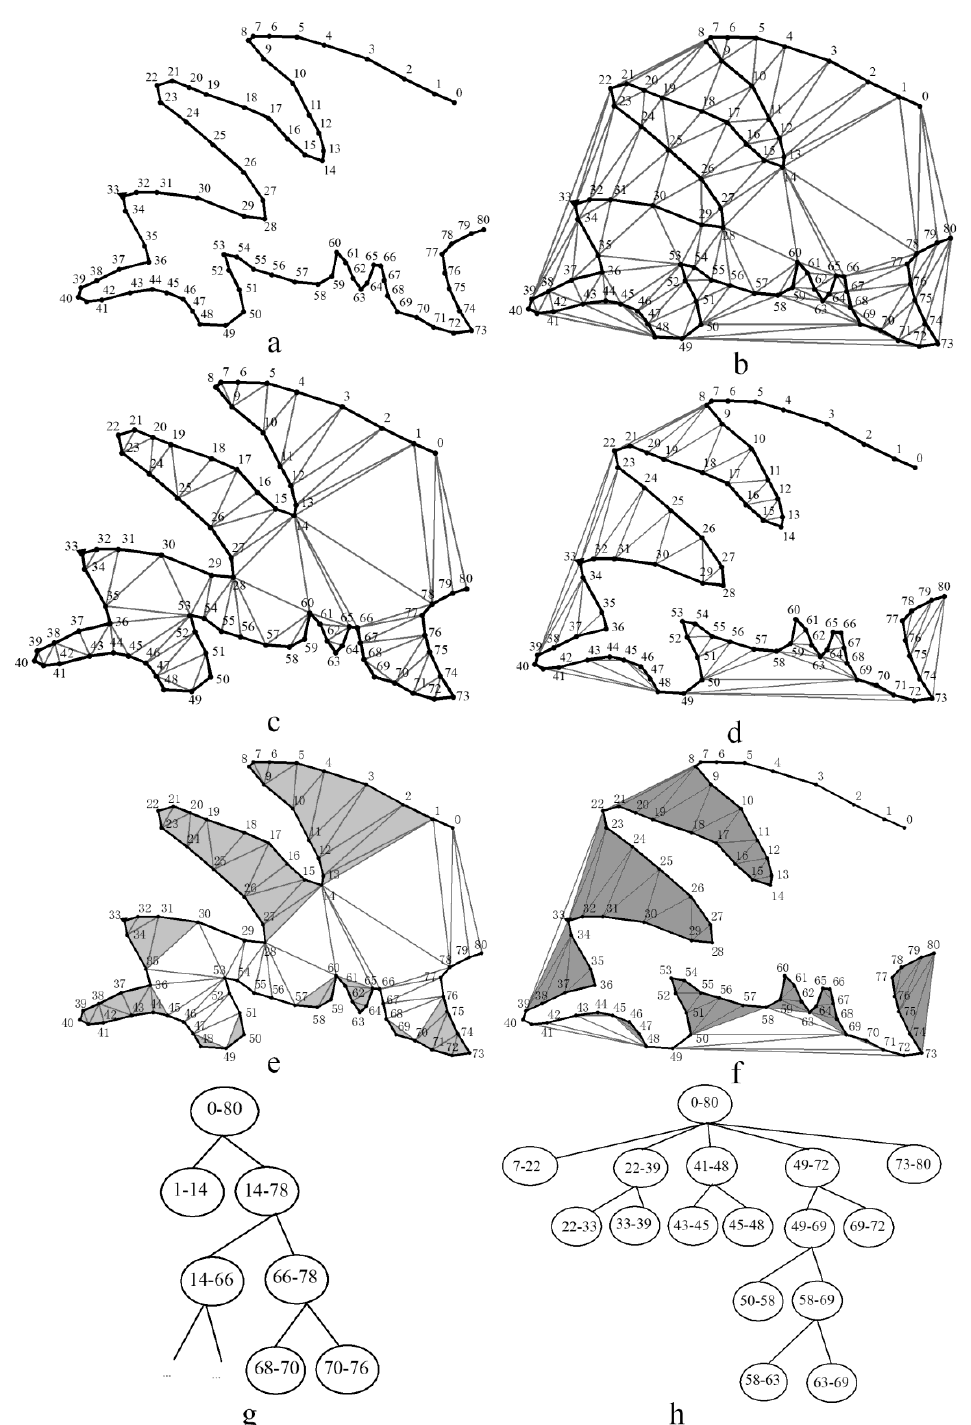
Figure 2. The process for identifying the graphical units of a curve. ( a ) An example curve with the order number of points on the curve. ( b ) Delaunay triangulation constructed with the curve points. ( c ) The triangulation sets on the left side of the forward direction of the curve. ( d ) The triangulation sets on the right of the forward direction of the curve. ( e ) The left-bend sets on the left of the forward direction of the curve. ( f ) The right-bend sets on the left of the forward direction of the curve. ( g ) The hierarchical structure of the left-side curve. ( h ) The hierarchical structure of the right-side curve.